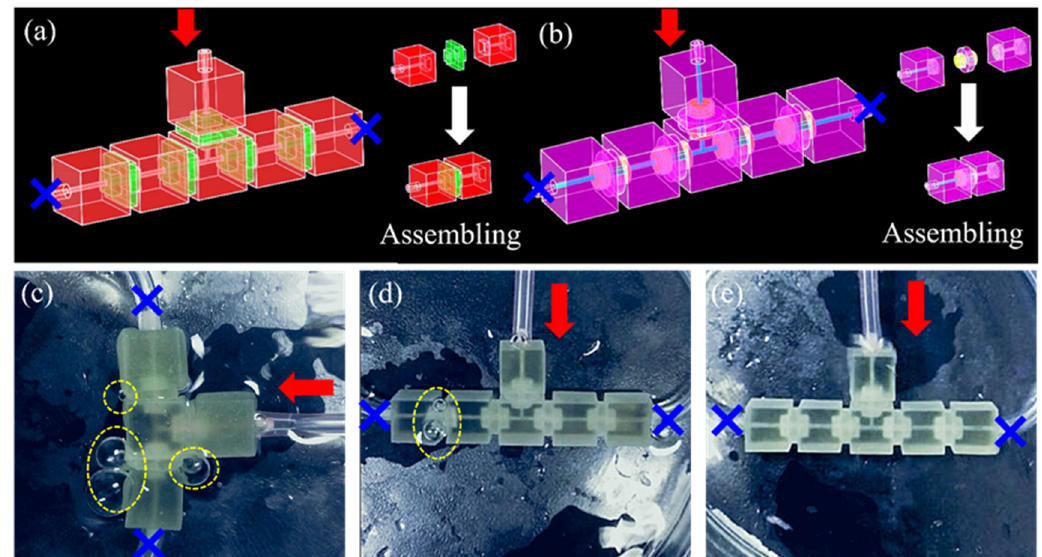
Figure 3. Connectivity of the modular microfluidic system. ( a ) schematic of modular assembly of embedded connections. ( b ) schematic illustration of modular assembly with threaded connections. ( c ) leakage experiment of embedded connected microfluidic system. ( d ) leakage experiment of threaded